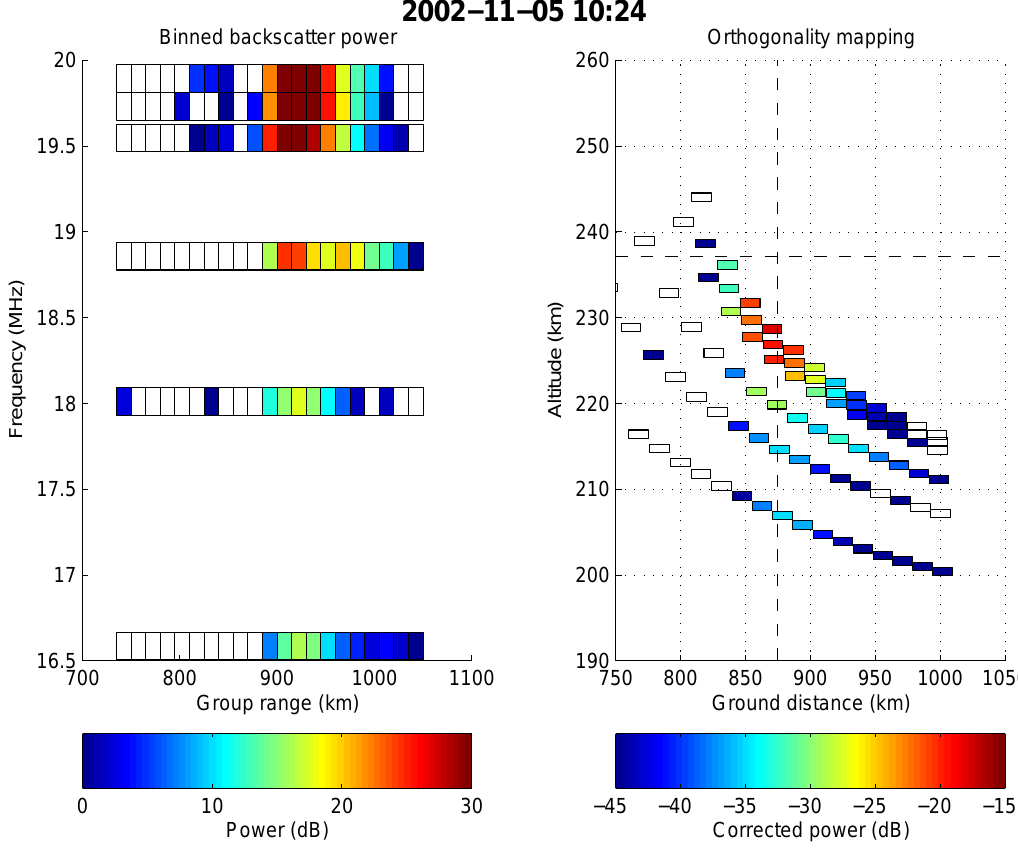
Fig. 4. Left panel: Backscatter power obtained by binning the backscatter power in Fig. 3 by frequency. Radar range gates where no scatter was detected are shown as empty boxes. Right panel: the data from the left panel mapped to the locations in the ionosphere where the scattering is occuring, assuming exact orthogonality. This mapping is carried out by means of ray-tracing results like those in Fig. 1. The horizontal dashed line indicates the upper-hybrid resonance height, determined from the electron density profile. The vertical dashed line indicates the ground distance of the heater from the CUTLASS radar. The power has been corrected for antenna gain and azimuthal